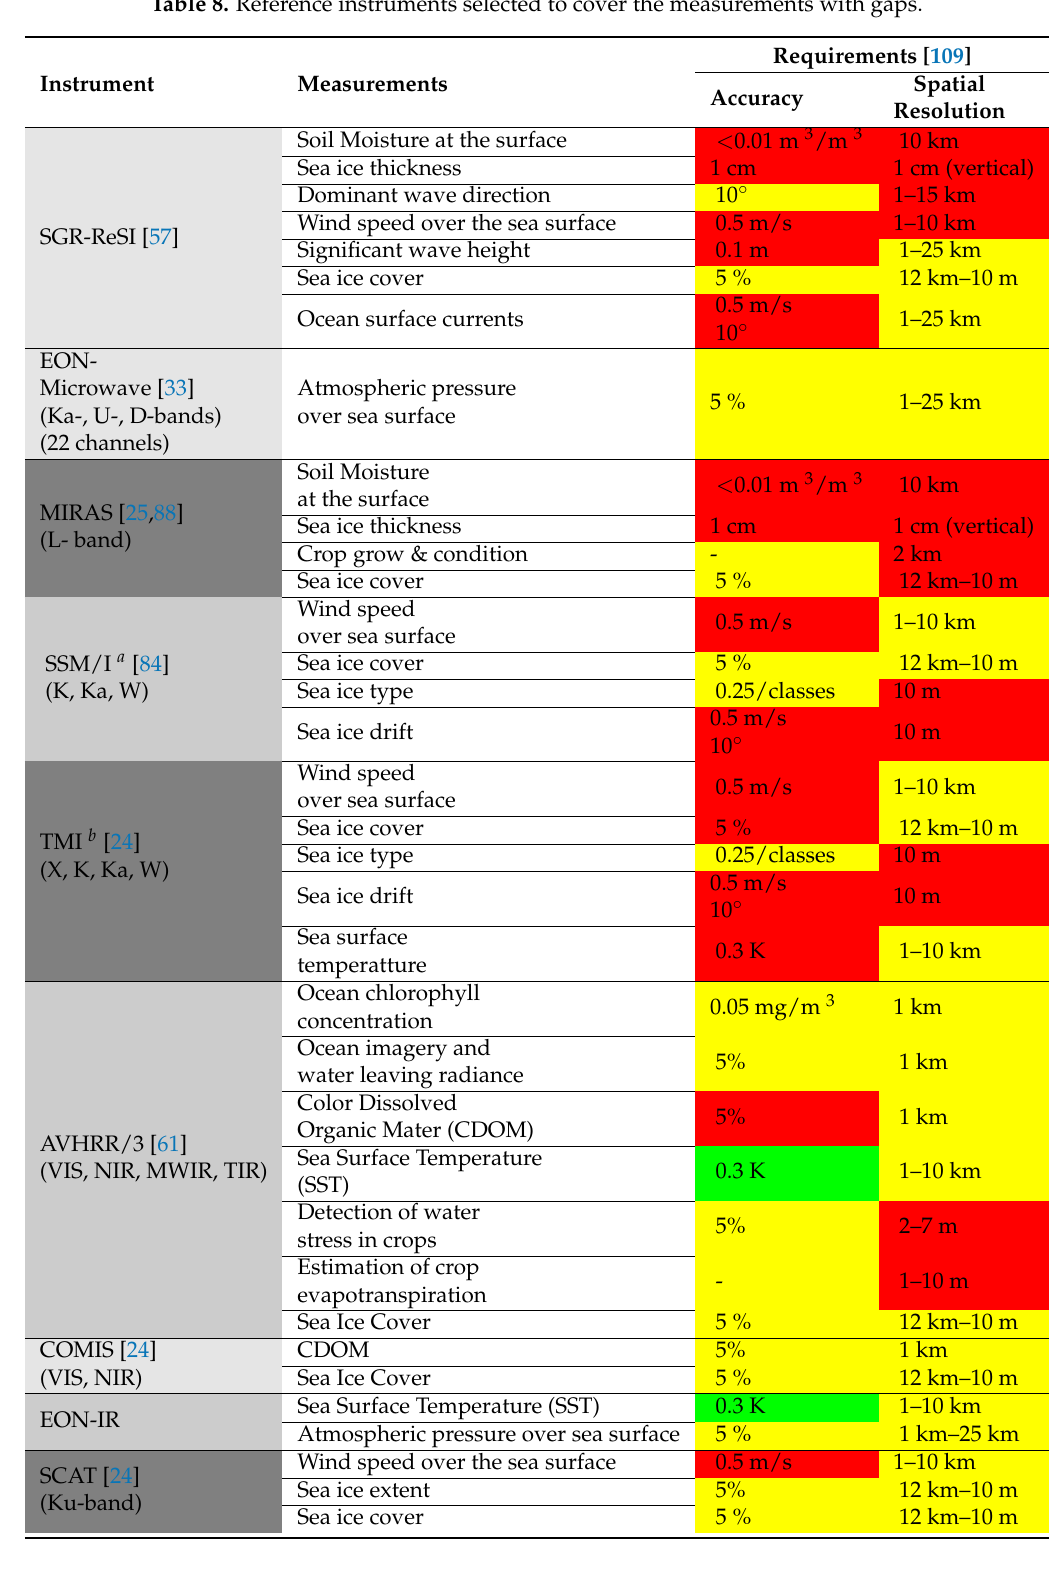
Table 8. Reference instruments selected to cover the measurements with